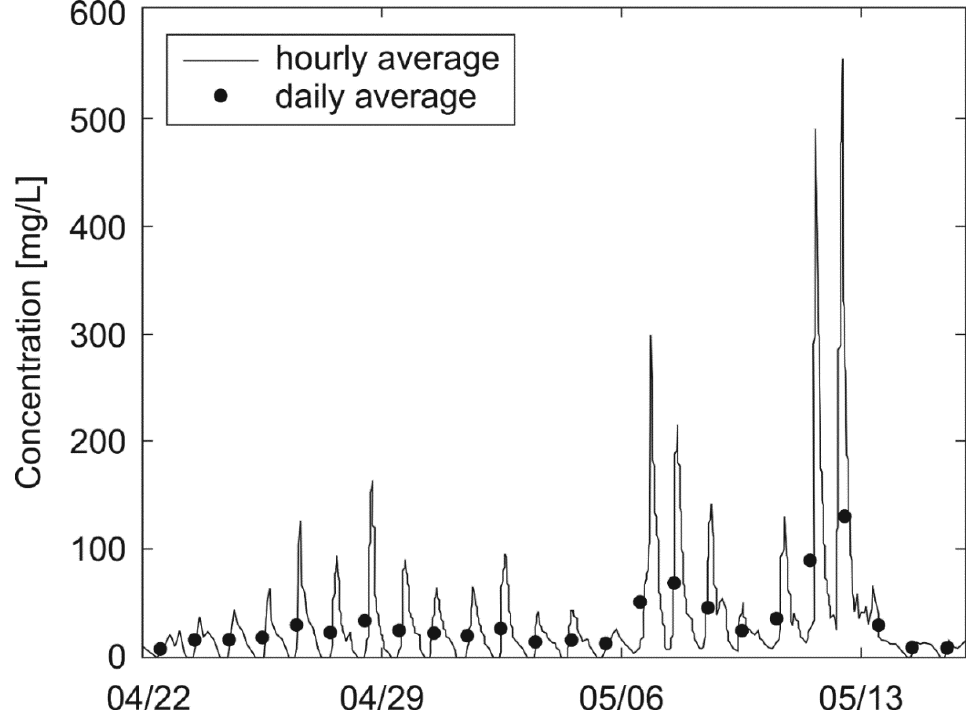
Figure 6. Concentration estimated from 2012 acoustic data at 2.24 m from the bed at a Nelson River site located 50 km downstream of the Limestone Generating Station. Adapted from [59], with authors’ permission.